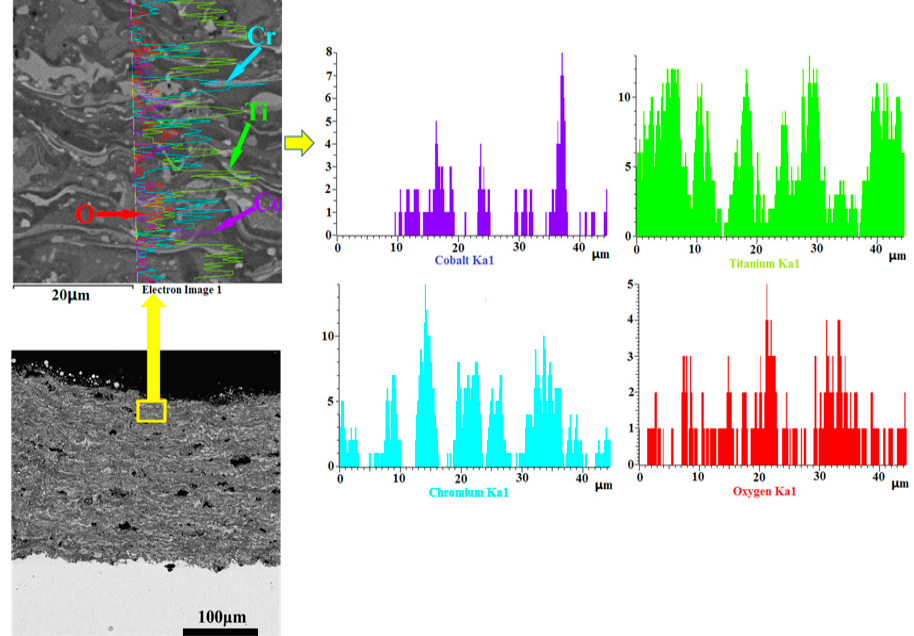
Figure 22. SEM image and EDS analysis of the TiB/CoCr coating after an immersion test in molten zinc for 360 h.